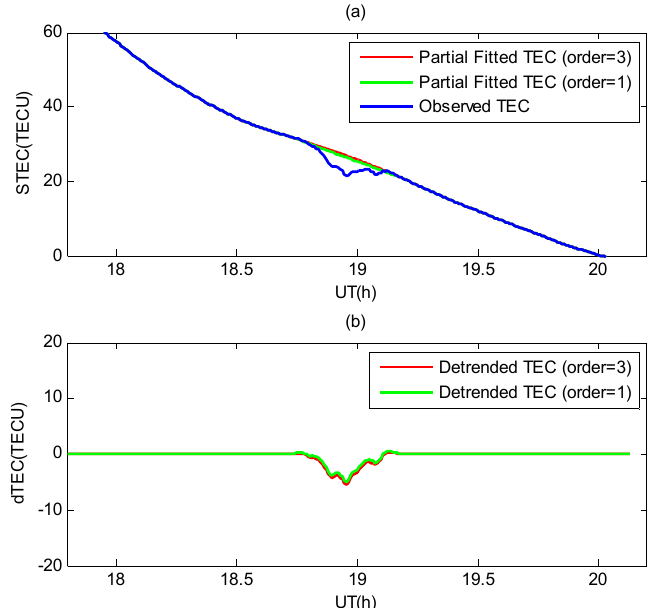
Figure 6. Same example in Figure 3 with first-order and third-order partial polynomial fitting. ( a ) Observed total electron content (TEC, blue line) and partially fitted TEC using first-order (green line) and third-order polynomial (red line); ( b ) detrended TEC by subtracting between the observed and partially fitted TEC (green line for first order and red line for third order).